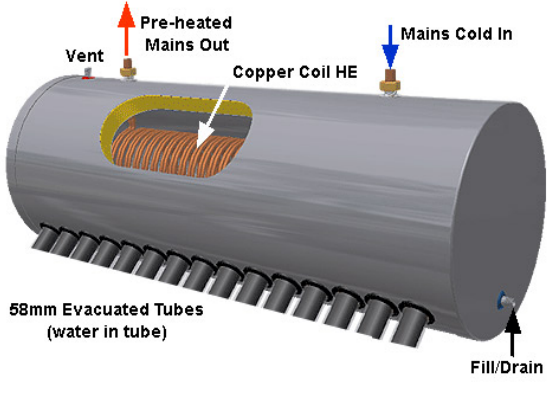
Fig. 1. Solar water heating